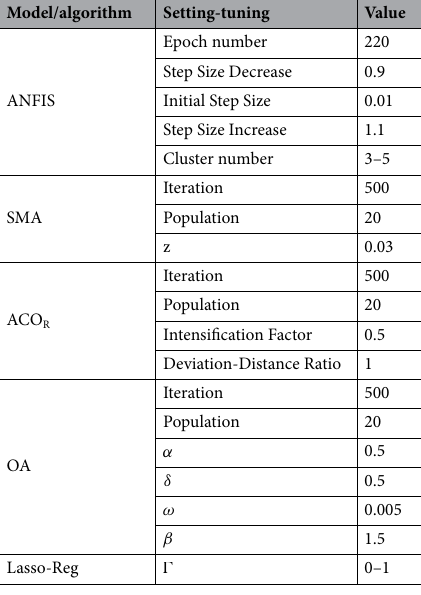
Table.3. Optimal setting parameters owing to the standalone ANFIS model, optimization algorithm, and Lasso-Reg model.